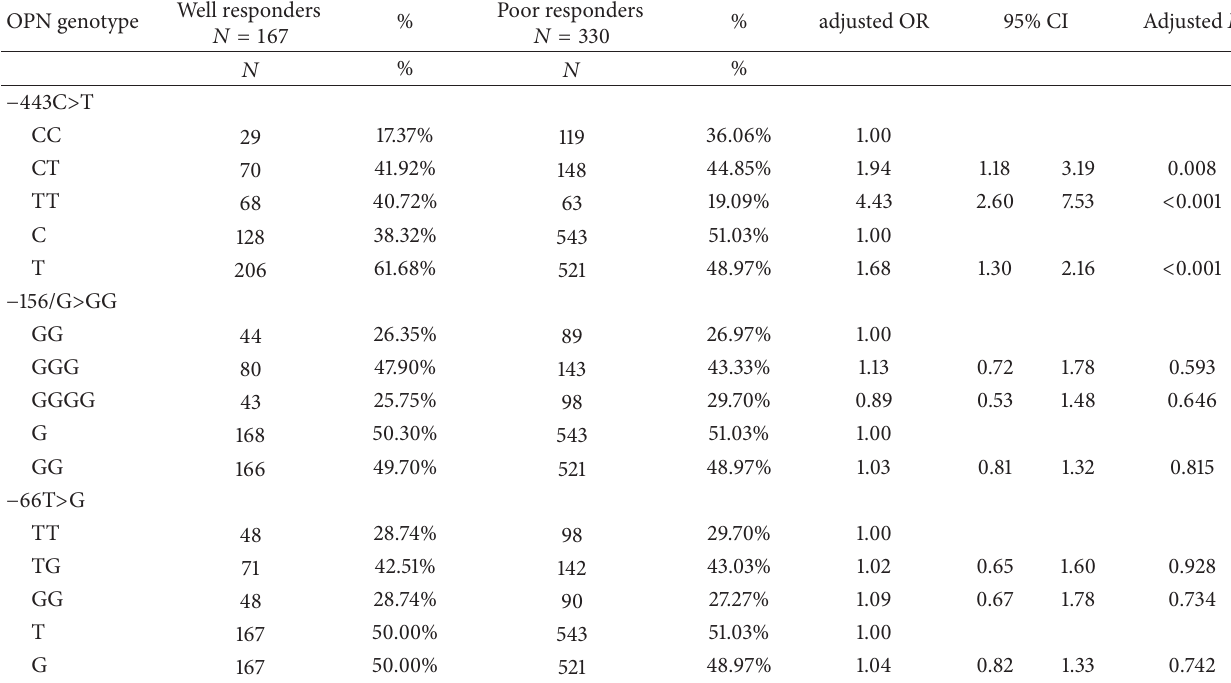
Table 2: The genotype frequencies for HIF-1 𝛼 polymorphisms between well responders and poor responders to platinum-based